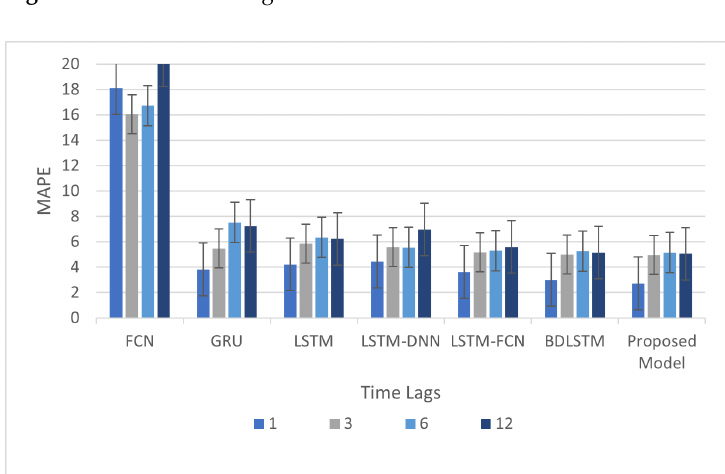
Figure 8. MAE vs. time lags.